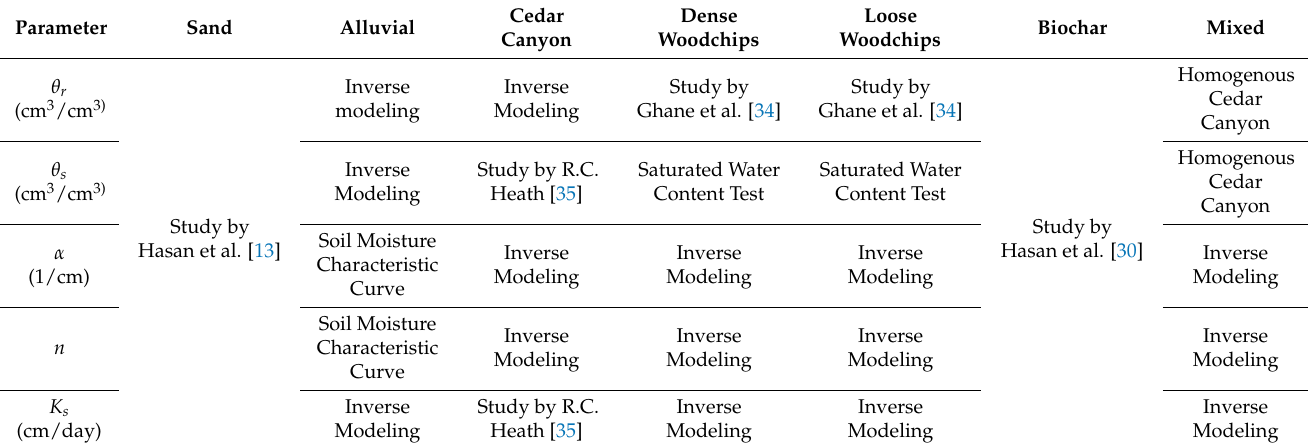
Table 1. Methods used to determine parameter